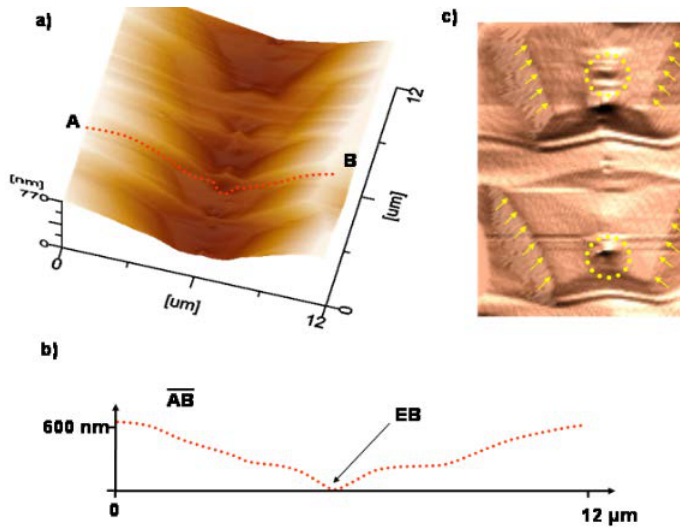
Figure 15. AFM 3D topography of etch pits along of the boundary (36.8°) ( a ) shows complicated shapes of the individual etch pits, which are dependent on bundle of dislocations and irregular distribution of dislocations on both sides of the boundary (see Figure 11). EB: etch pits of the bundle ( b ), EG: etch pits of the band of dislocations ( c ).